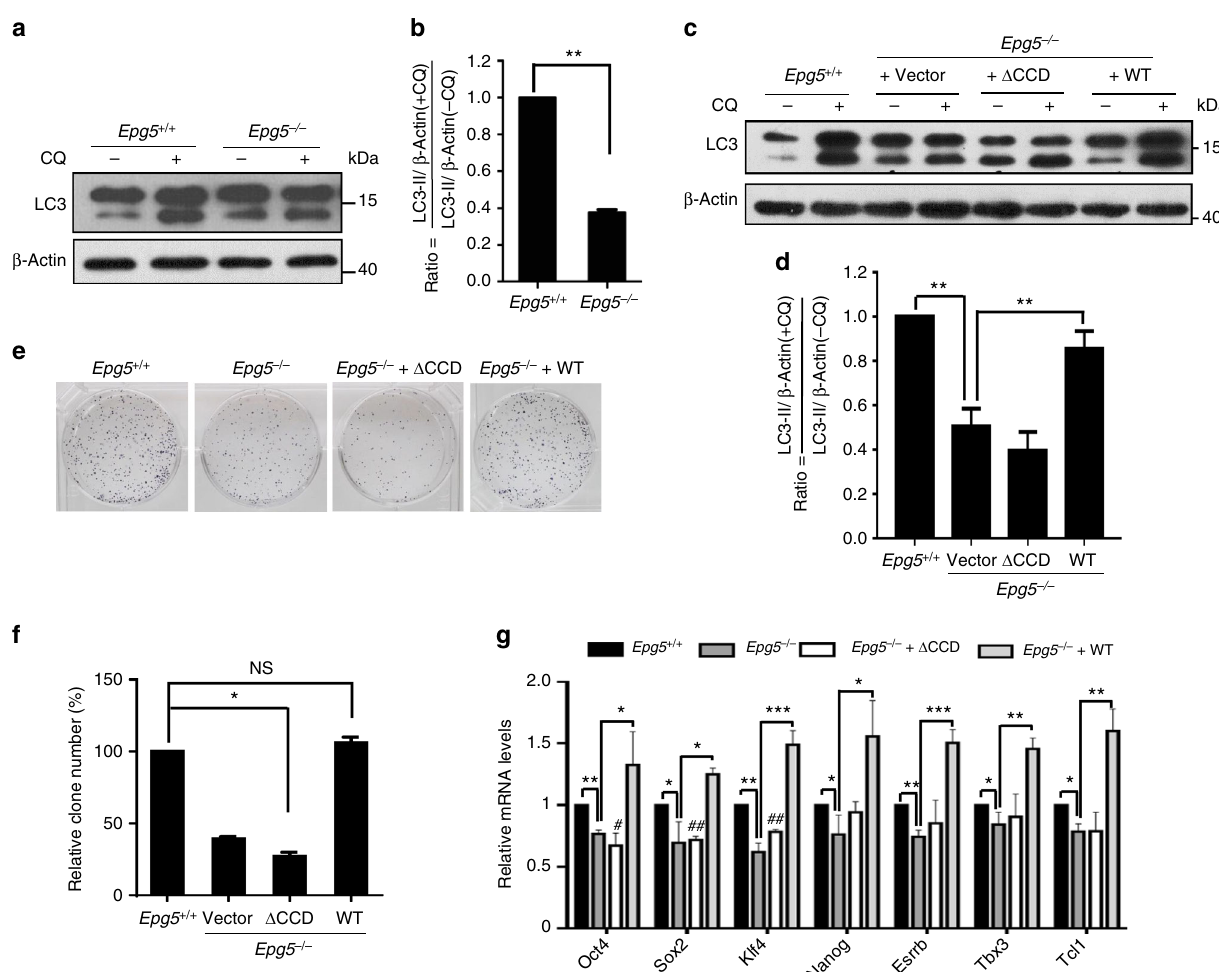
Fig. 2 EPG5 depends on its coiled-coil domain to regulate ESC identity. a Western blotting for LC3 and β -actin in Epg5 + / + and Epg5 − / − ESCs. β -Actin served as a loading control. Samples were treated with or without the autophagy inhibitor chloroquine (50 μ M) for 2 h. Images are representative of three independent experiments. b Quanti fi cation of autophagic fl ux in a by calculating the ratio of LC3-II with or without CQ treatment. Error bars indicate the SD ( n = 3). Three independent biological replicates. ** P < 0.01 by unpaired two-tailed Student ’ s t test. c Introduction of wild-type Epg5 but not an Epg5 mutant lacking the coiled-coil domain ( Δ CCD) into Epg5 − / − cells ameliorates the impaired autophagic fl ux. d Quanti fi cation of the autophagic fl ux by calculating the ratio of LC3-II with or without CQ treatment in c . Error bars indicate the SD ( n = 3). Three independent biological replicates. ** P < 0.01 by unpaired two-tailed Student ’ s t test. e , f Introduction of WT Epg5 but not the Δ CCD Epg5 mutant into Epg5 − / − cells restored the colony-formation ability. ESC colonies were stained with AP. Error bars indicate the SD ( n = 3). Three independent biological replicates. NS not signi fi cant. * P < 0.05 by unpaired two- tailed Student ’ s t test. g Reduced pluripotency gene expression in Epg5 − / − ESCs is rescued by introduction of WT Epg5 but not the Δ CCD Epg5 mutant. Error bars indicate the SD ( n = 3). Three independent biological replicates. * P < 0.05, ** P < 0.01, *** P < 0.001, # P < 0.05, ## P < 0.01 by unpaired